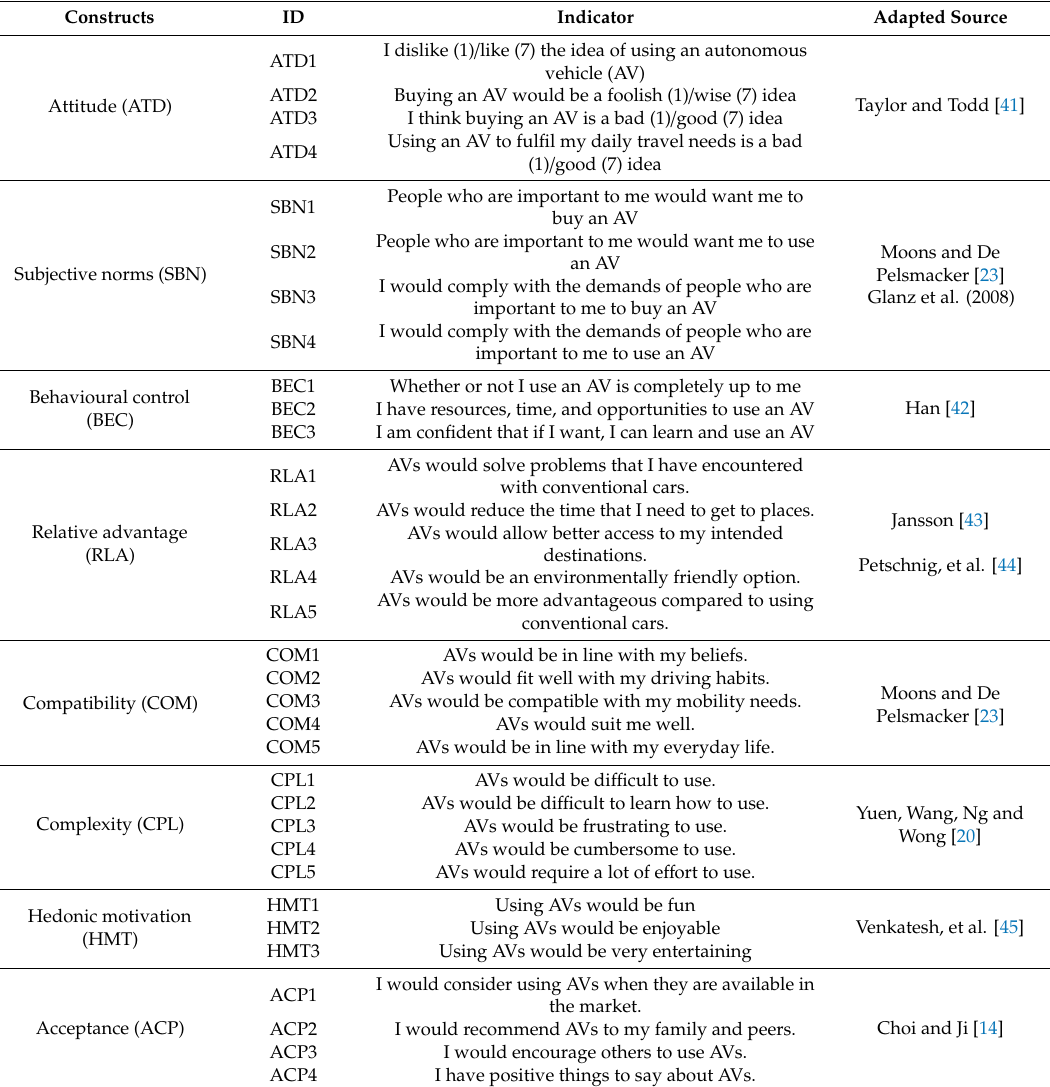
Table 1. Constructs and